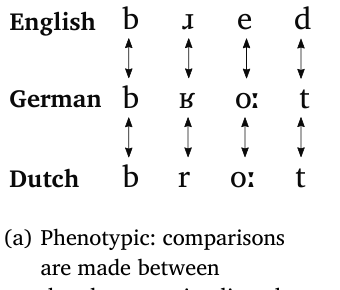
methods, when comparing